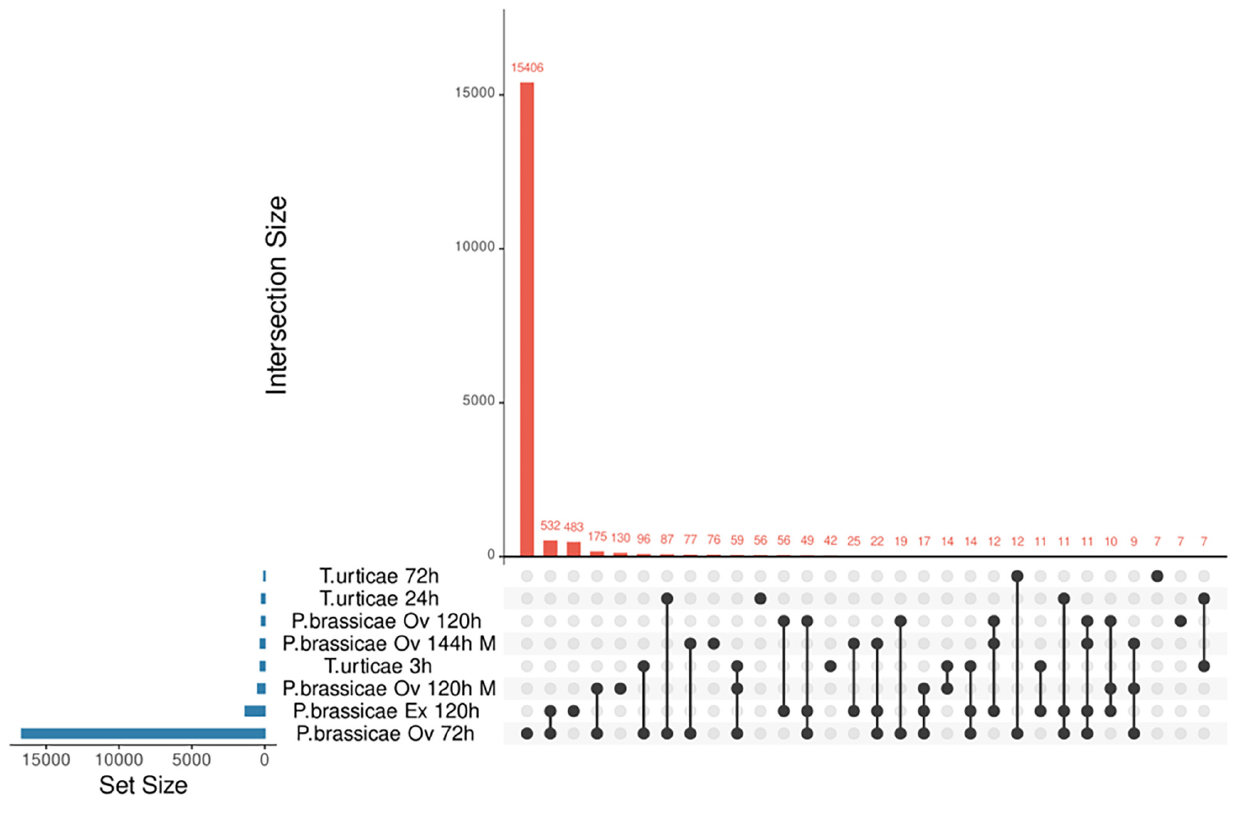
FIGURE 2 | Upset diagram of unique and common DEGs found in A. thaliana under oviposition or egg extract stresses. Each study is identified by the pest name, followed by the identification of the stress: oviposition (Ov) or egg extract (Ex) and the time of analysis (h). All T. urticae data were obtained from egg extract stress. Microarray results are identified by an (M), the rest of the results were obtained from RNA-seq